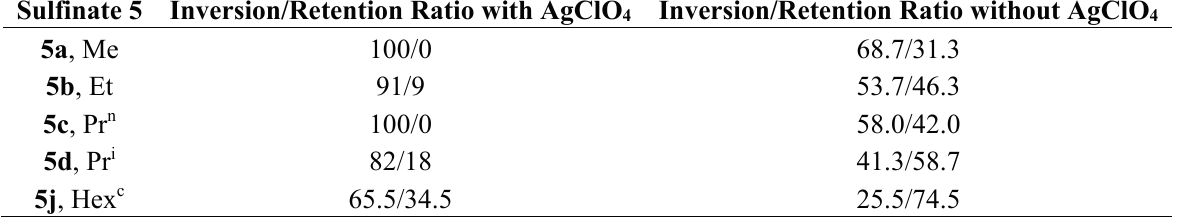
Table 5. The effect of silver perchlorate on steric course of the acid catalyzed alcoholysis of sulfinamide (+)-( S )- 1c